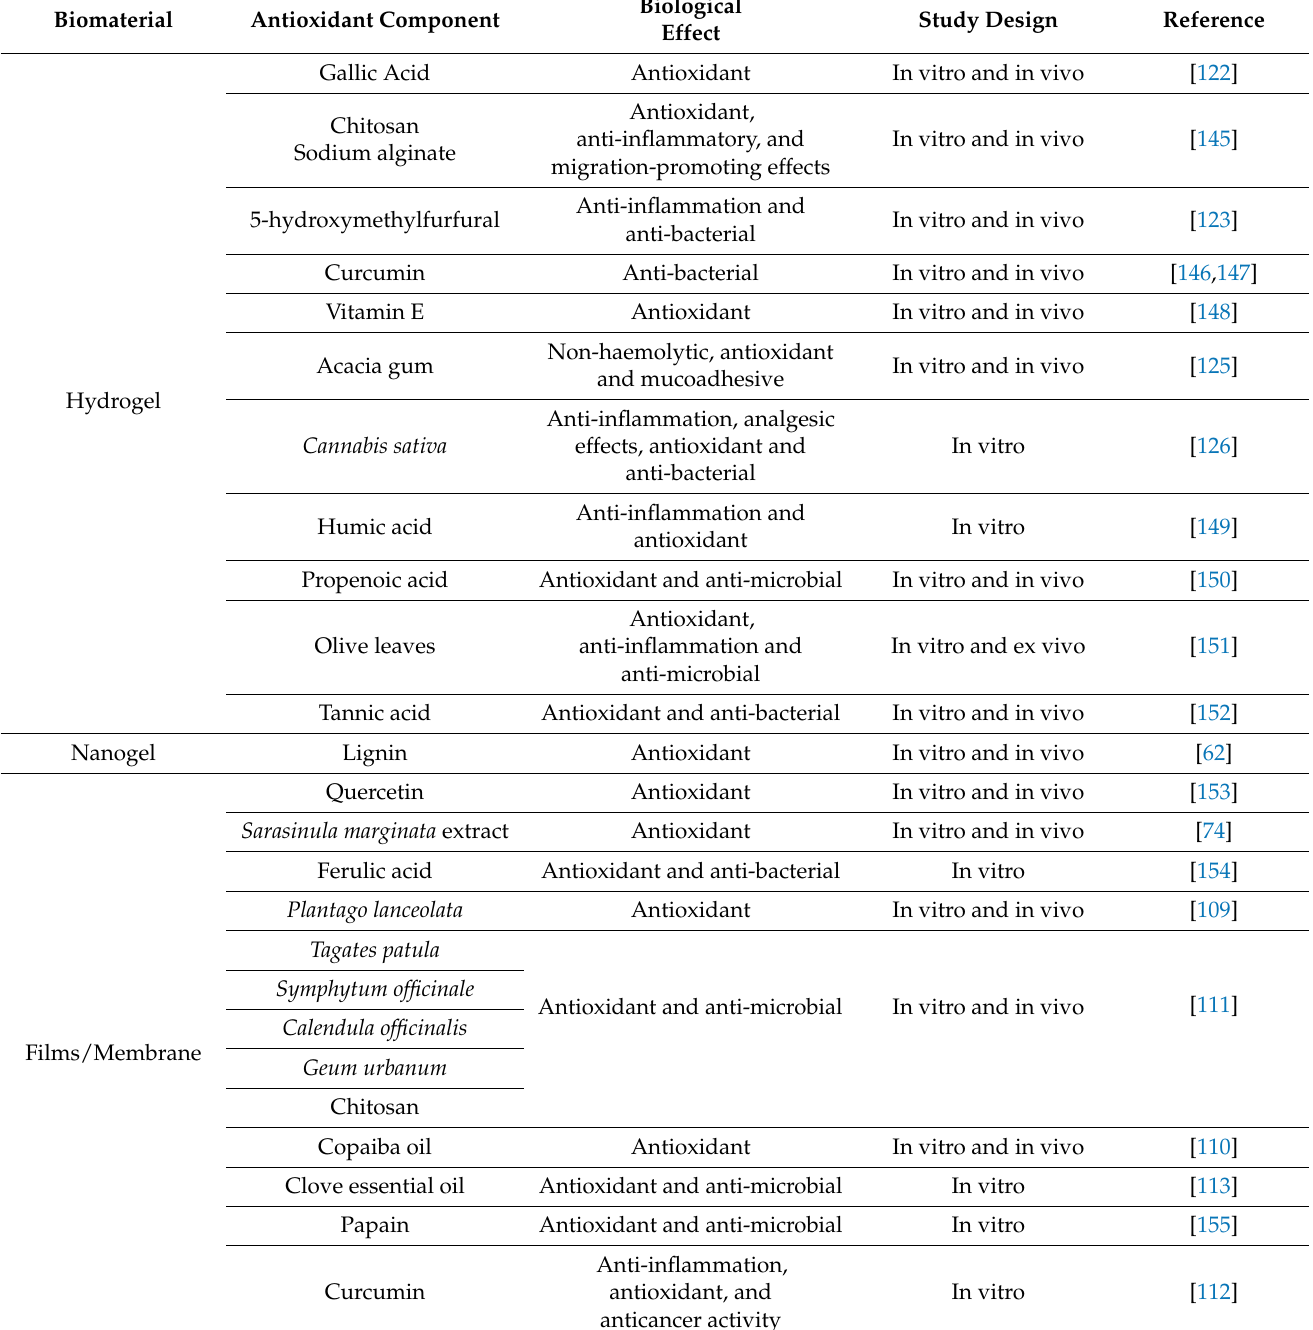
Table 2. The available studies of biomaterials incorporated with antioxidant